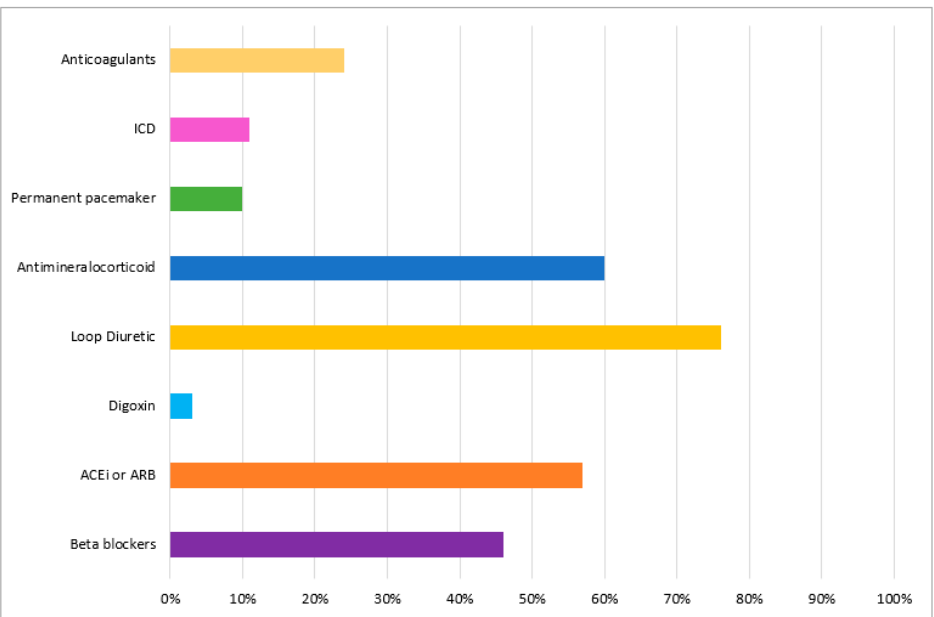
Figure 5. Participants’ options for heart failure treatment in patients with cardiac amyloidosis. ACEi—angiotensin converting enzyme inhibitor; ARB—angiotensin receptor blocker; ICD—implantable cardioverter defibrillator.